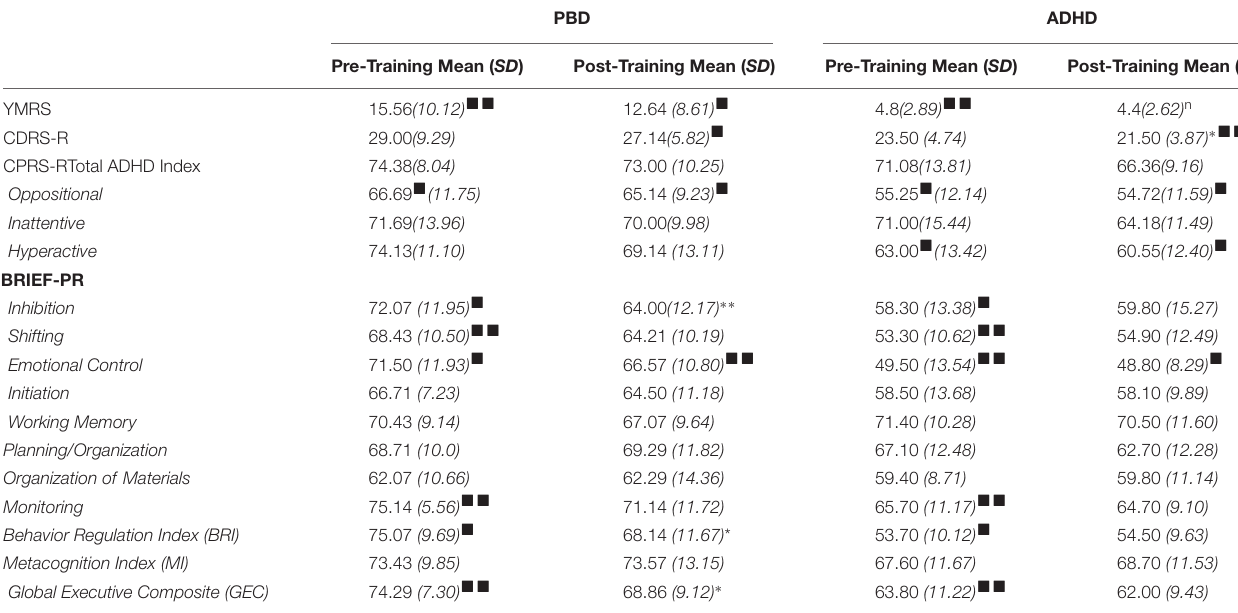
TABLE 3 | Pre- and post-training clinical scale scores for patients with PBD and patients with